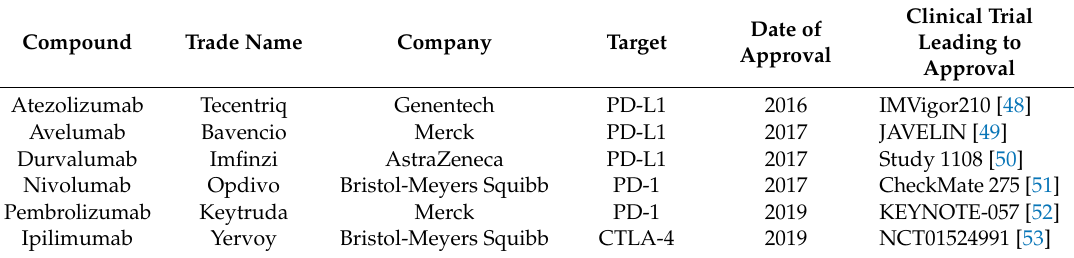
Table 1. List of approved checkpoint inhibitors used in bladder cancer